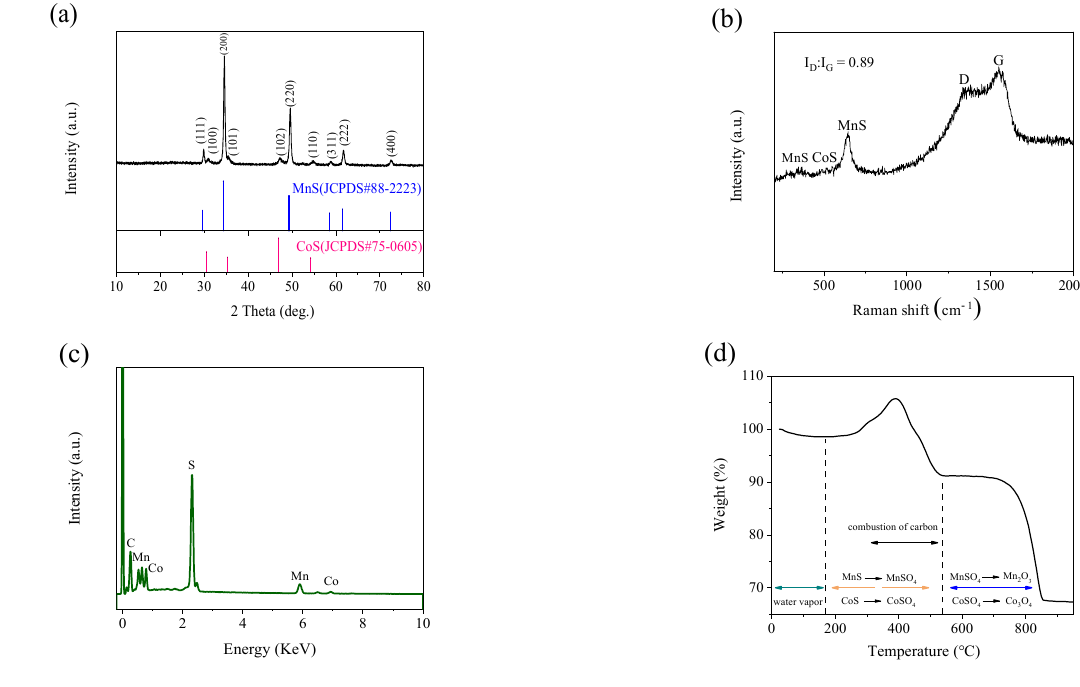
Figure 4. ( a ) XRD pattern, ( b ) Raman spectrum, ( c ) EDS pattern and ( d ) TGA curve in air of